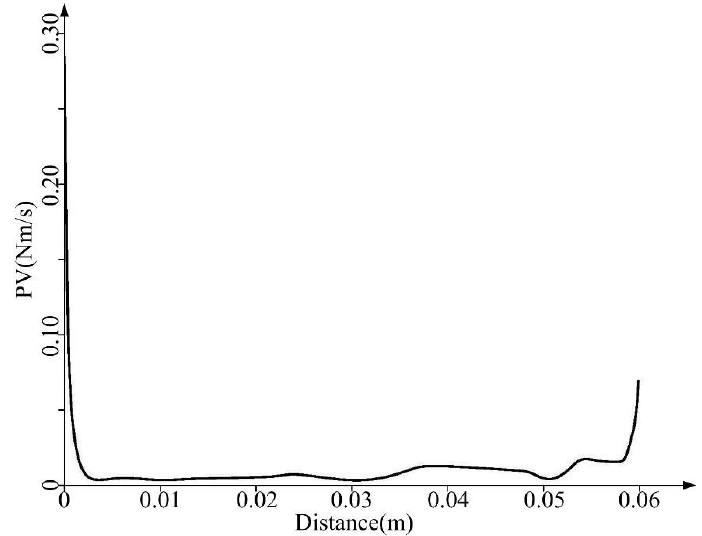
Figure 17. The product of forced and velocity of particles in the optimized flow passage.